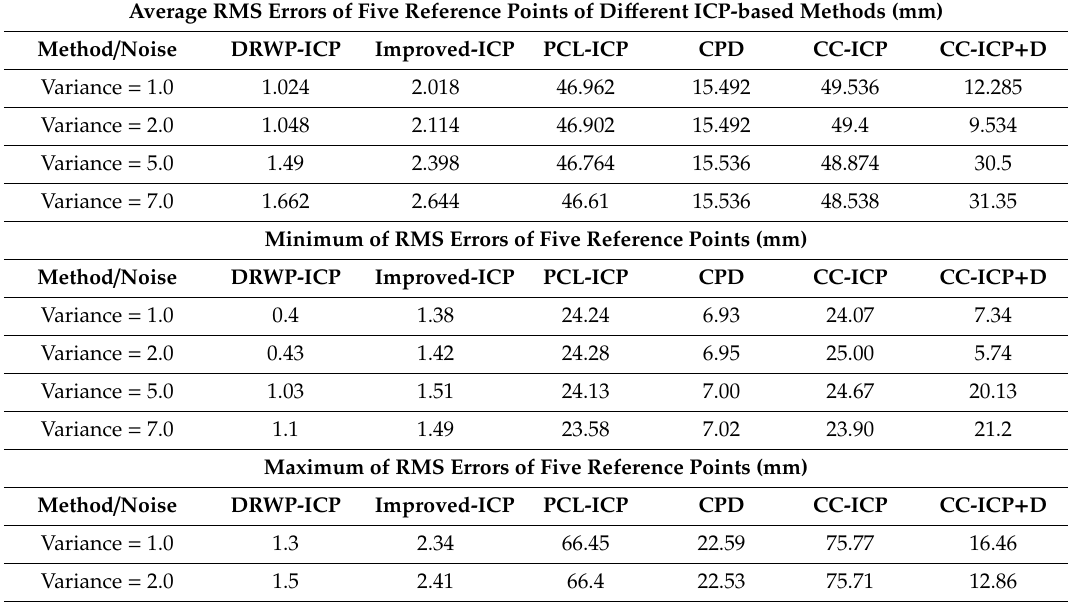
Table 3. The Average, Minimum and Maximum of Reference Points’ Alignment Errors.